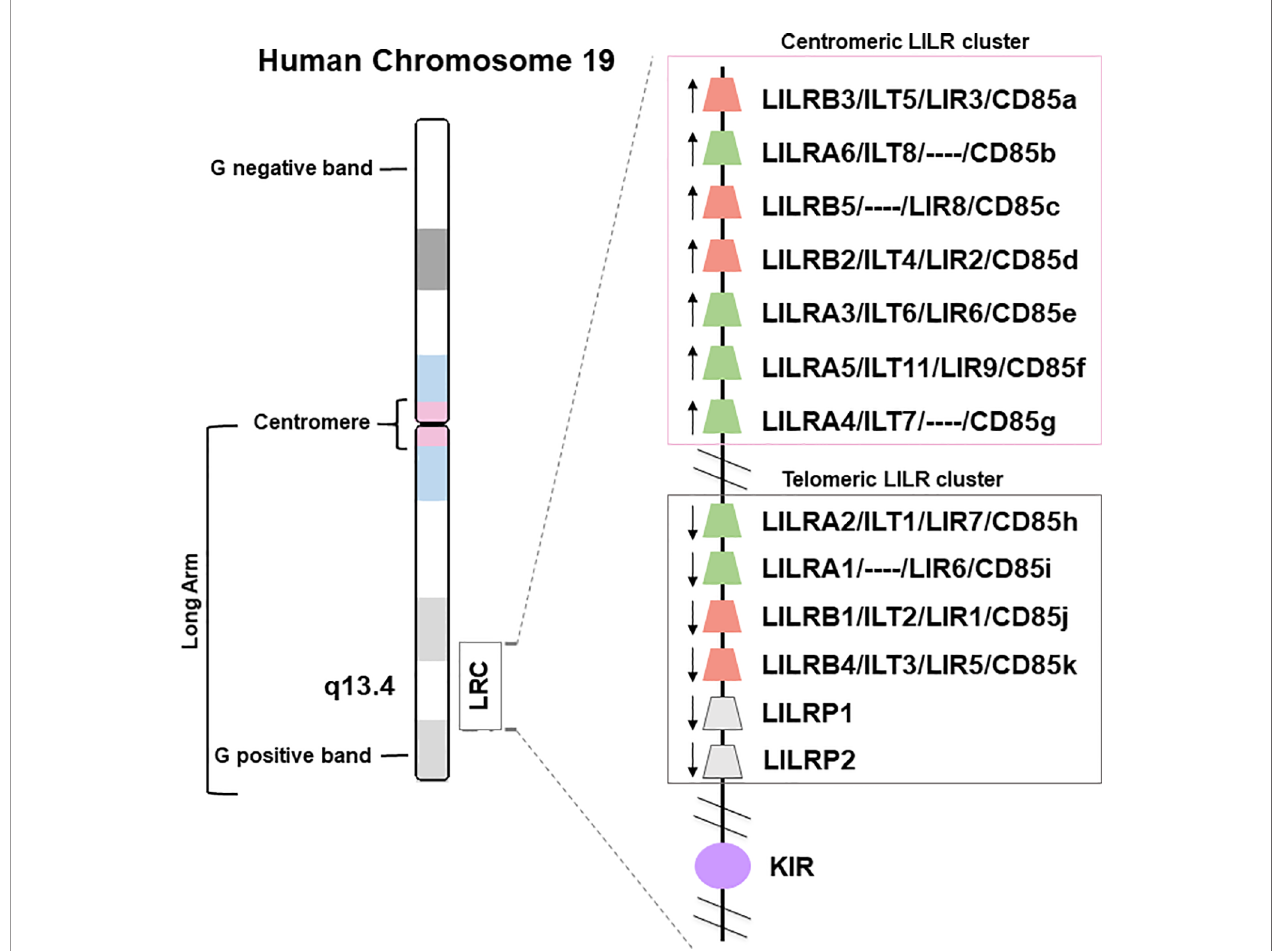
FIGURE 1 | Genomic organization of the LILR gene cluster. The leukocyte immunoglobulin-like receptor (LILR) gene family is located on human chromosome 19q13.4, within the leukocyte receptor complex (LRC). The thirteen LILR genes are distributed into a centromeric and a telomeric cluster with opposite transcription orientations ( ! ). A, activating (green); B, inhibitory (red); P, pseudogenes (grey); KIR, killer-cell immunoglobulin-like receptor